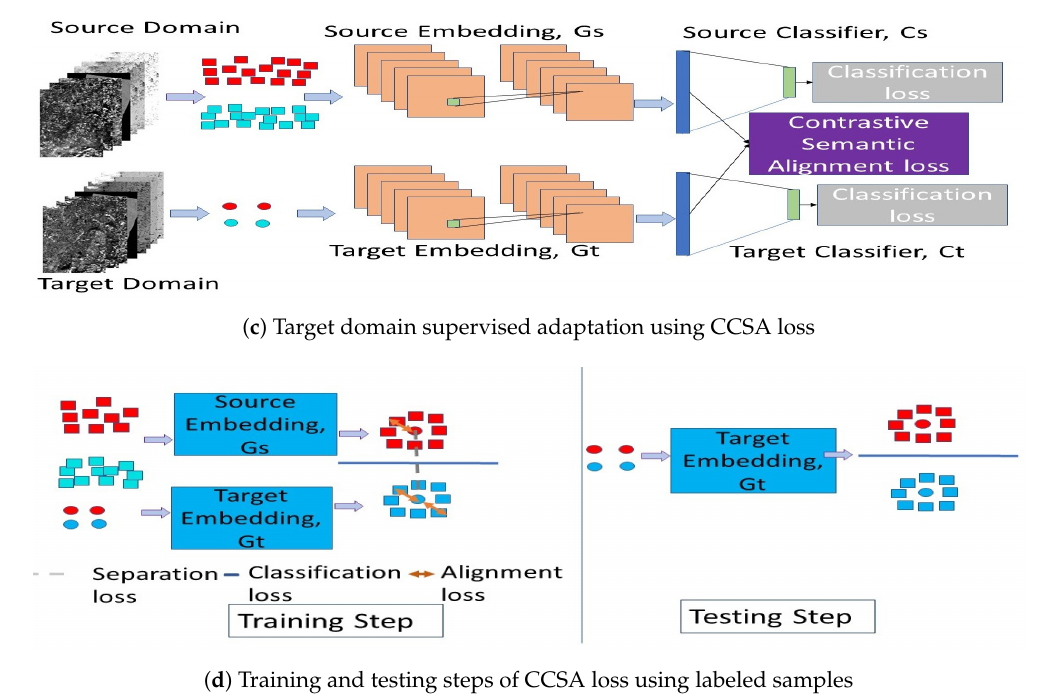
Figure 6. Semi-supervised domain adaptation (SSDA) method for flood